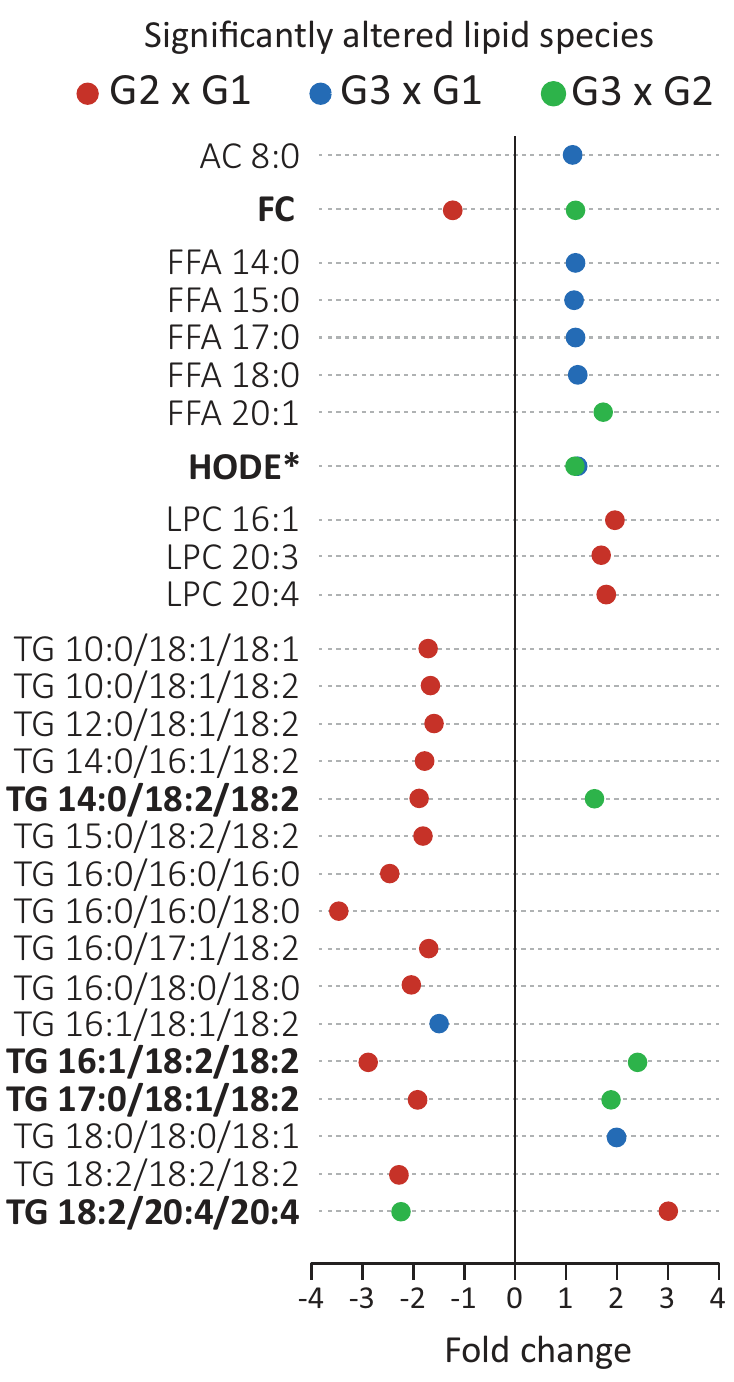
Fig 2. Major alterations in plasma lipidome of newborns caused by ZIKV infection. Fold-change of significantly altered lipids in pairwise comparisons (t-test; p < 0.05). Lipid species in bold represent features that displayed significant differences in concentration in more than one contrast (G2 x G1 and G3 x G2). Concentrations of selected lipid species are shown in S2 Fig for comparison. HODE � emphasizes that this Oxy-FA was elevated in G3 relative to the other groups. Abbreviations for lipid classes are depicted in Table 1 or in the main text. Fatty acyl chains are represented by X:Y, where X denotes the number of carbons and Y the number of double